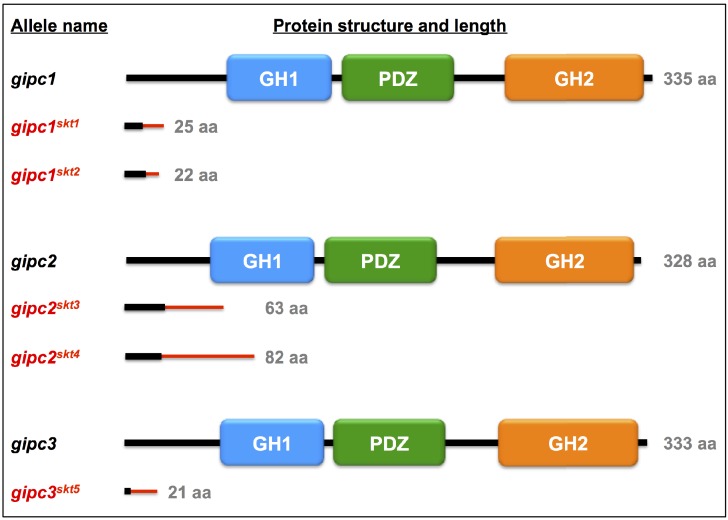
GIPC proteins encoded by both the wild-type and mutant gipc1, gipc2, and gipc3 alleles.In the mutant proteins, the red bar denotes novel amino acid sequences resulting from mutagenic frameshift(s). See Supplementary file 1 and Supplementary file 8. Related to Figure 4.